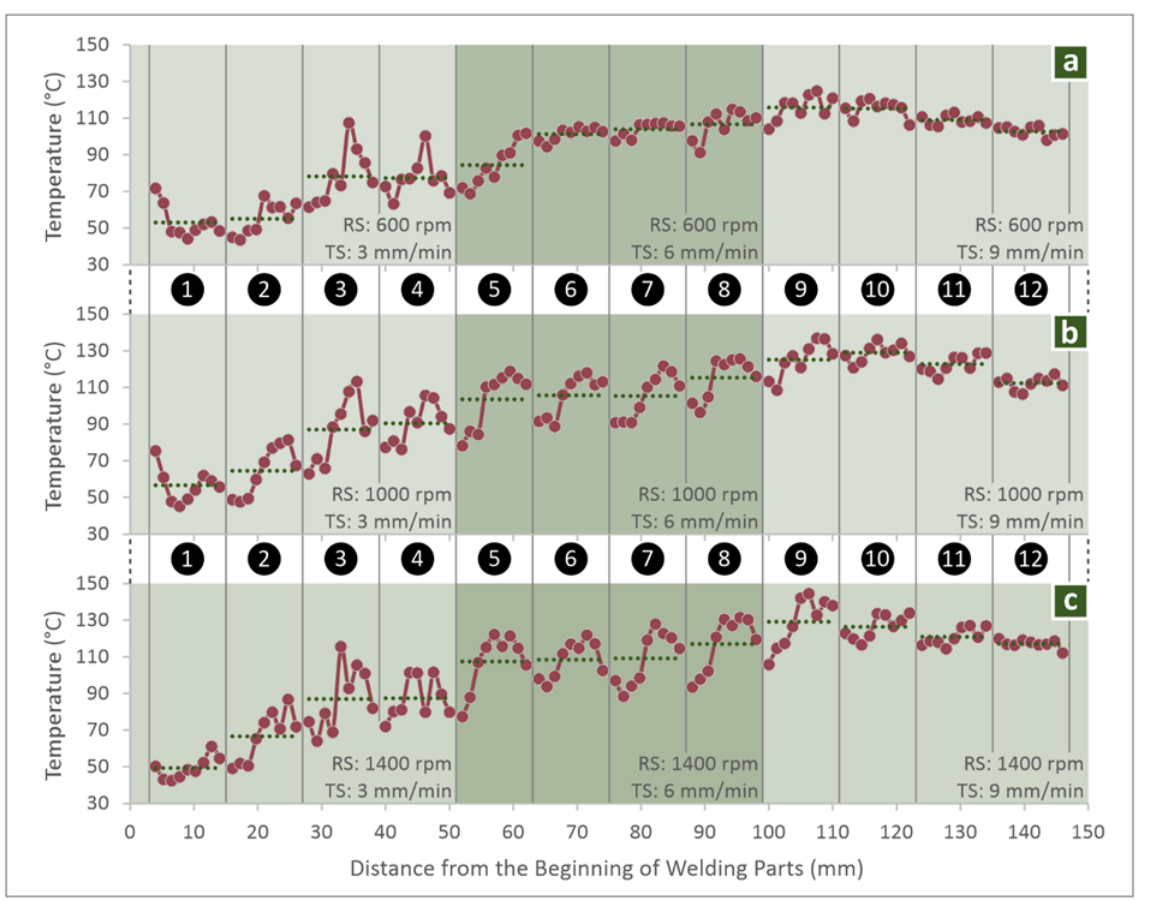
Figure 10. Temperature course for each specimen made with the PPB tool. Specimen welded with 3, 6 and 9 mm/min TS and ( a ) 600 rpm, ( b ) 1000 rpm, ( c ) 1400